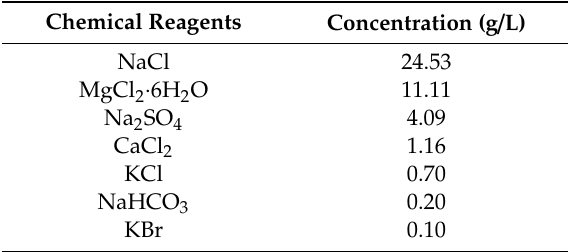
Table 1. Composition of artificial seawater in immersion